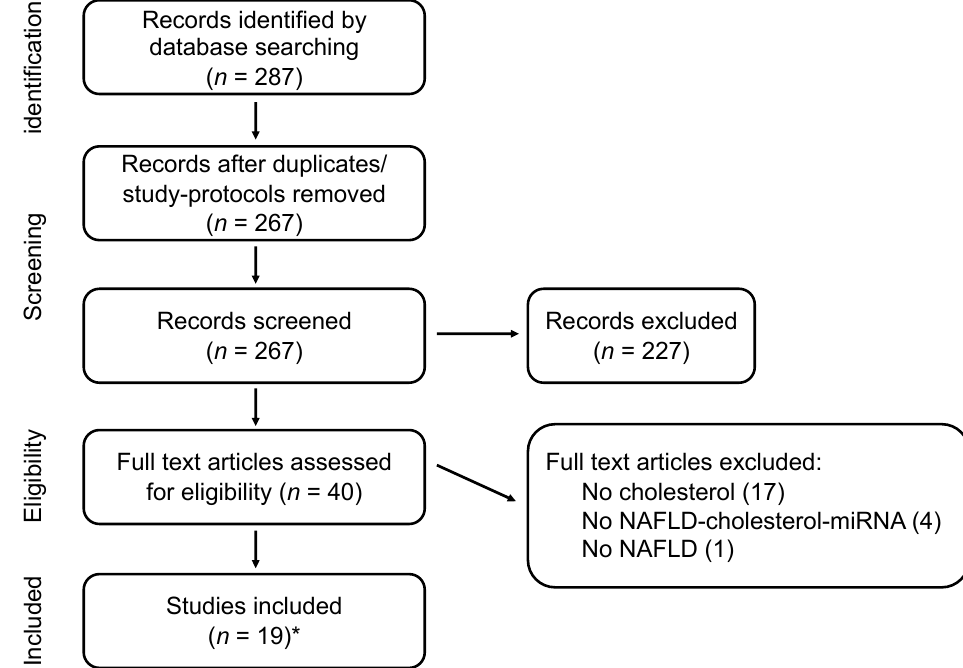
Figure 1. Flow chart of the study selection process. The literature search retrieved 287 potentially relevant papers; 228 were excluded after screening titles and abstracts, 40 articles were reviewed in full and ultimately 19 studies were included in the systematic review. * One study included from the reference list of the selected papers.